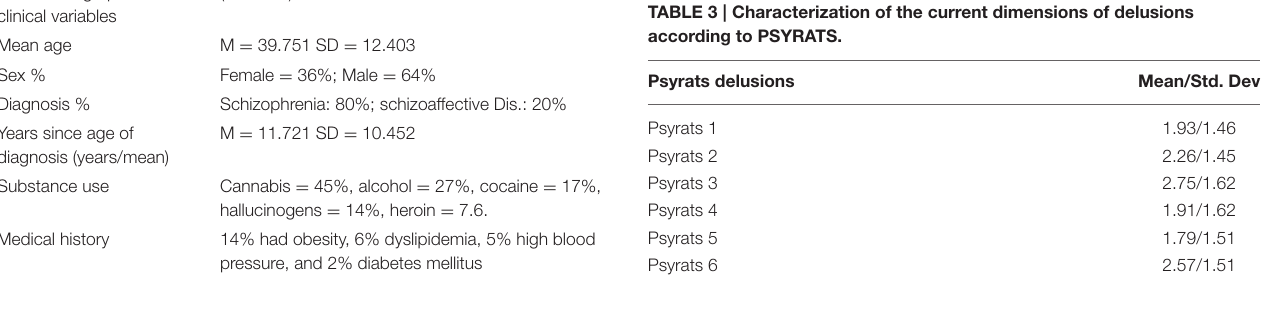
TABLE 1 | Sociodemographic and clinical variables variables. Sociodemographic and clinical variables